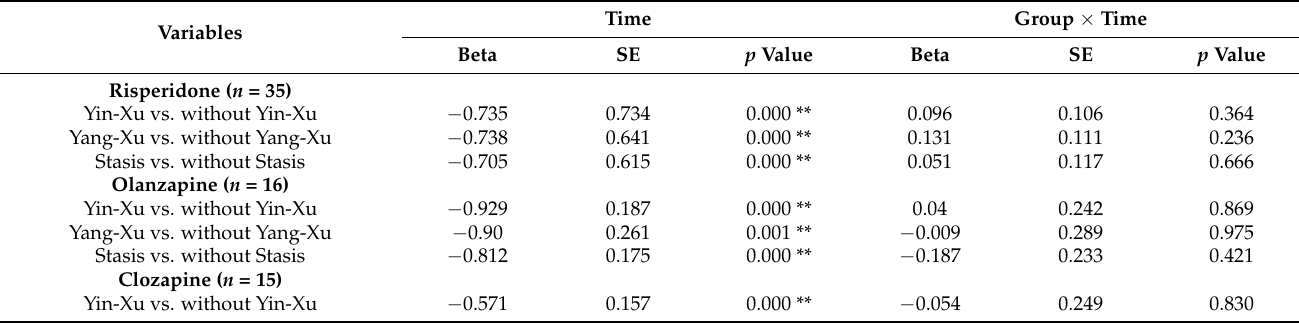
Table 4. General estimating equation for the comparison of CGI between different BC types within each SGA treatment group within the study’s time frame.